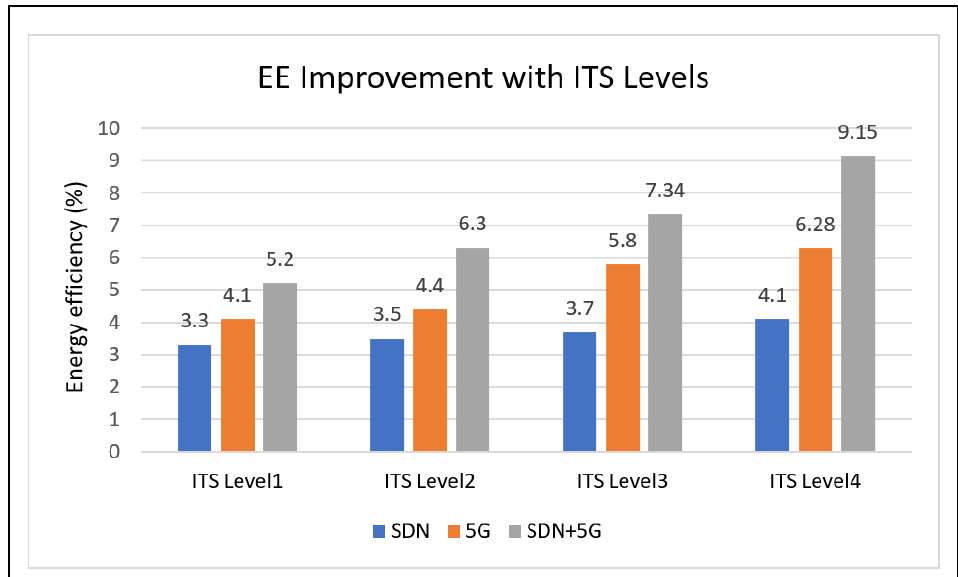
Figure 6. Comparison of EE with the levels of ITS.